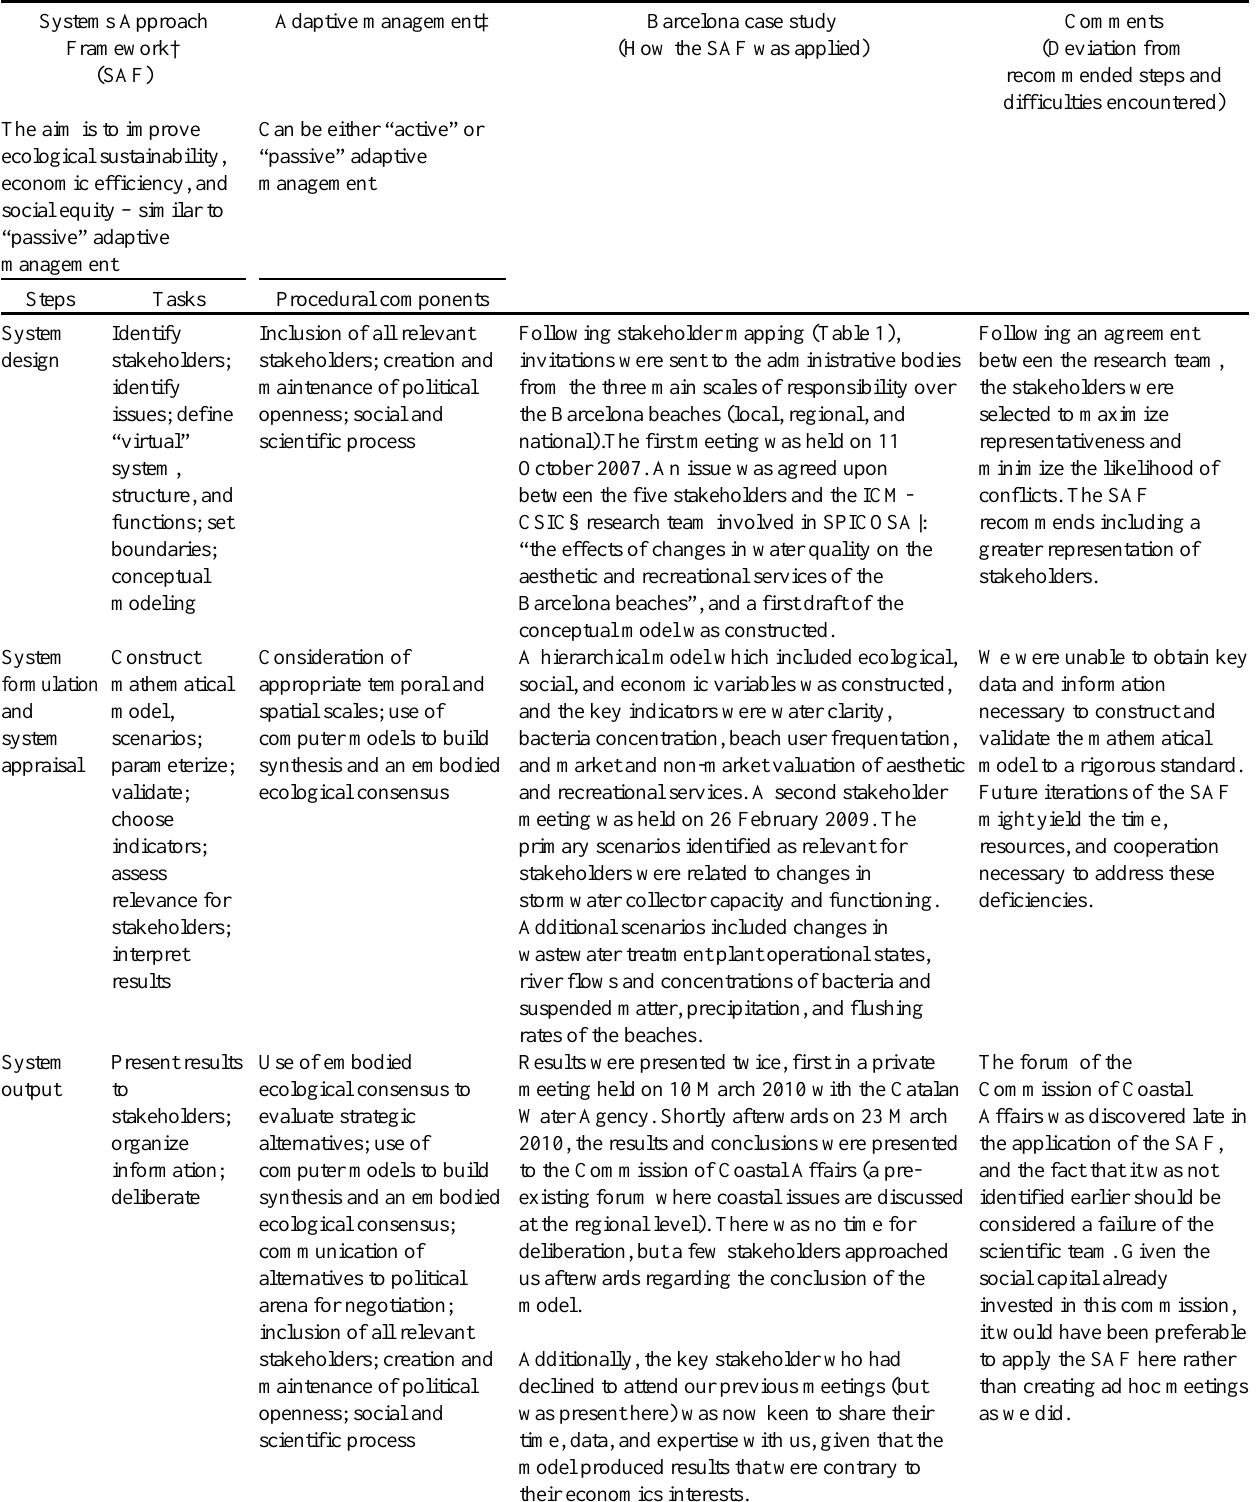
Table 3 . Comparison of the Systems Approach Framework (SAF) and adaptive management: application of SAF to Barcelona. Systems